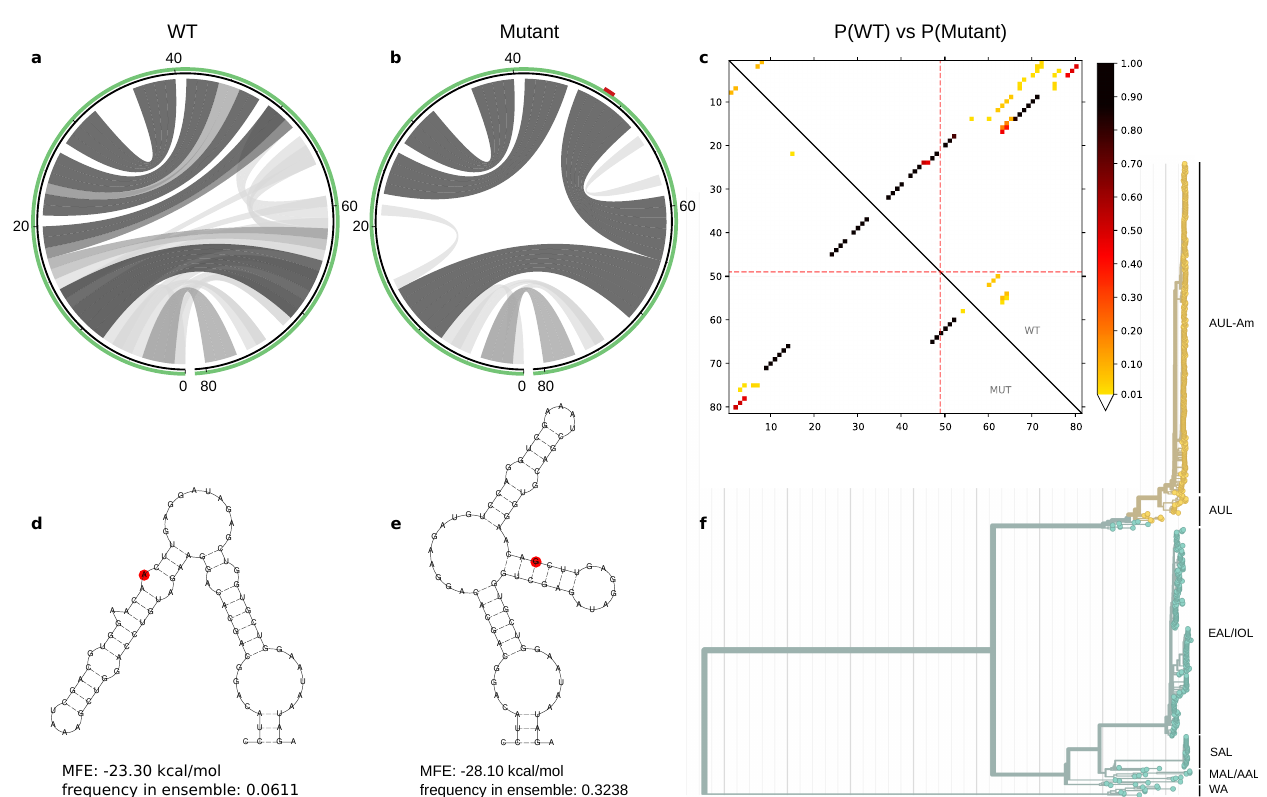
Figure 3. Ensemble properties of the 81˙nt locally stable RNA element that contains the A1653G variant, represented as A49G here. Different patterns of base-pair probabilities of the wild type (WT) and mutant are shown as circle plots in ( a , b ), with darker arcs corresponding to increased base pairing probability. The SNV position in ( b ) is highlighted in red within the green circle that represents the RNA backbone. The dot plot in ( c ) shows the differences in base pairing potential of both WT (upper triangle) an mutant (lower triangle), with dark dots indicating high base pairing probability of particular sequence positions. Red dotted lines indicate the mutated position. Minimum free energy structures of the WT and mutant are shown in ( d , e ), respectively, with the mutated position highlighted in red. The A1653G mutation results in a thermodynamic stabilization by 4.8 kcal/mol. This mutation is specific to AUL, and in particular to AUL-Am isolates, highlighted in yellow in the time-resolved phylogenetic tree in ( f